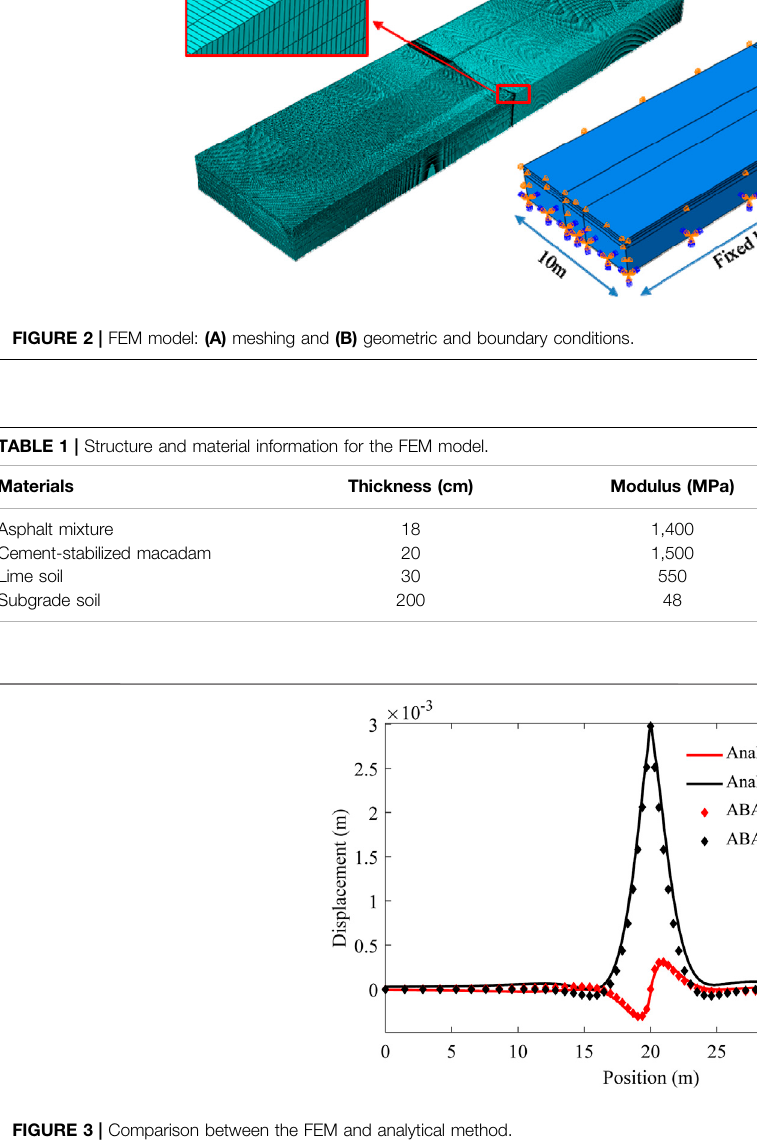
Figure 4 outlines the fi eld test setup, sensor installation, and rolling process.